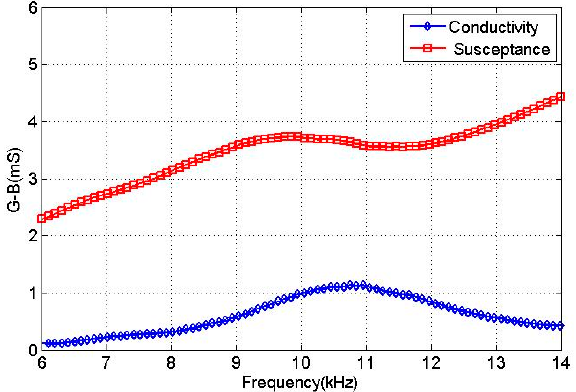
Figure 13. Conductance curves of the transducer under dipole vibration in water.